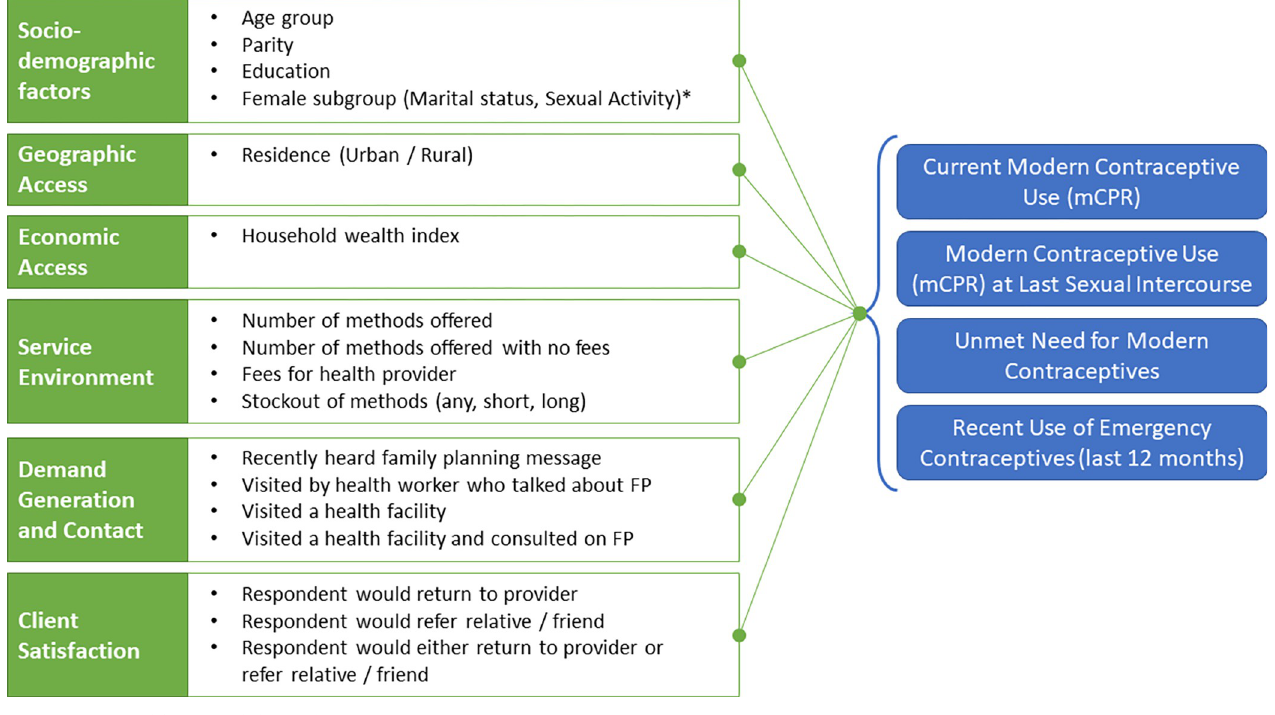
Fig 1. Conceptual framework for